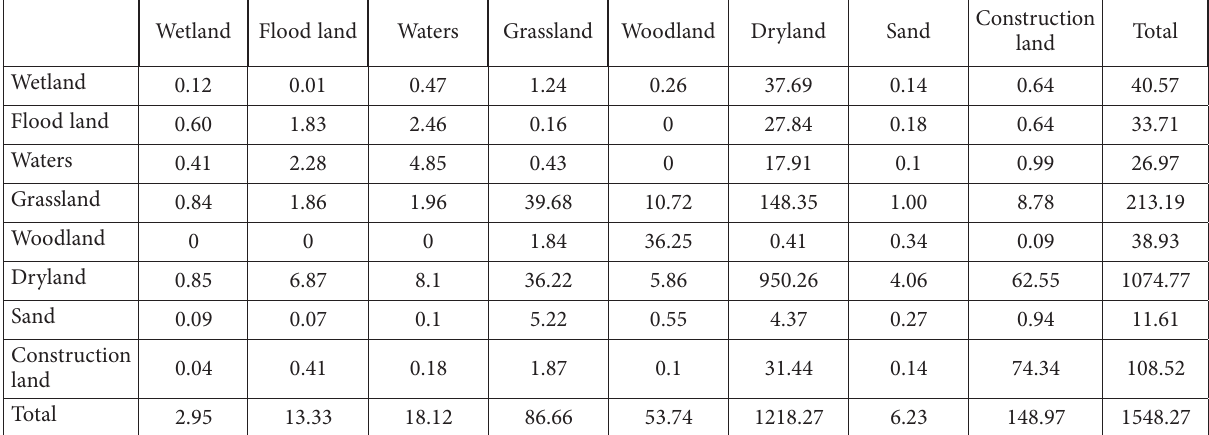
Table 5. Area transfer matrix of West Liao River Estuary land use from 1985 to 2015 (km 2 )